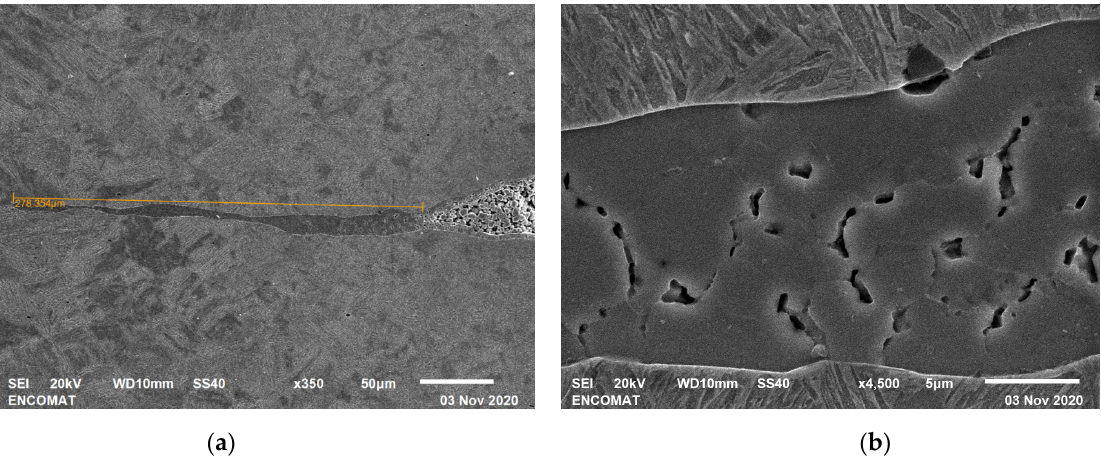
Figure 10. SEM of D Proy for f = 7000 Hz: ( a ) the interface ( b ) detail of Zn in the interface.